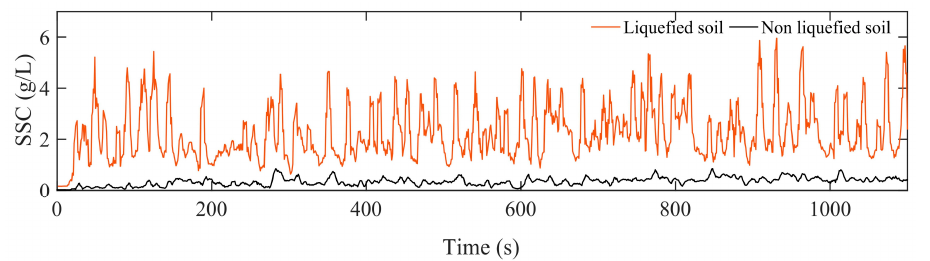
Figure 9. Change in SSC with time (at 5 cm above the seabed): red line—liquefied seabed (Experiment IV-2); and black line—non-liquefied seabed (Experiment II-3).